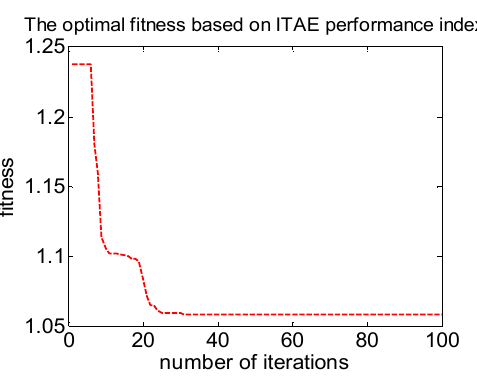
Figure 13. The optimization of PID parameters by using PSO algorithm. ( a ) K p , K d ; ( b ) K i .